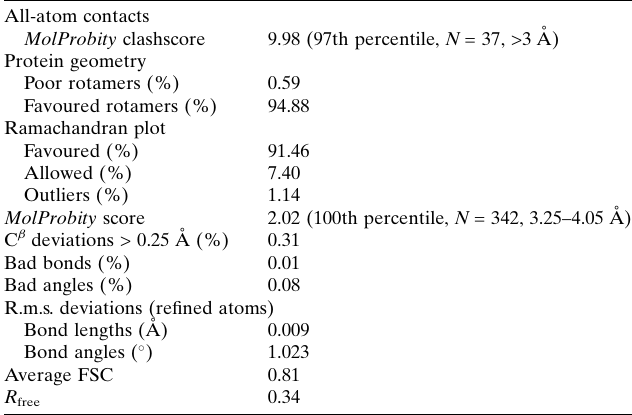
Table 1 Model-refinement statistics.